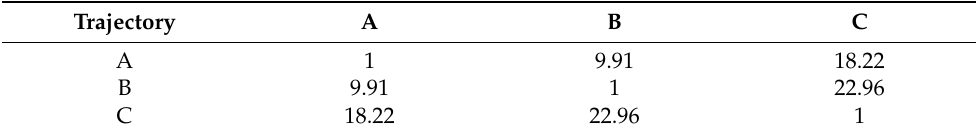
Table 8. Distances between trajectories A, B and